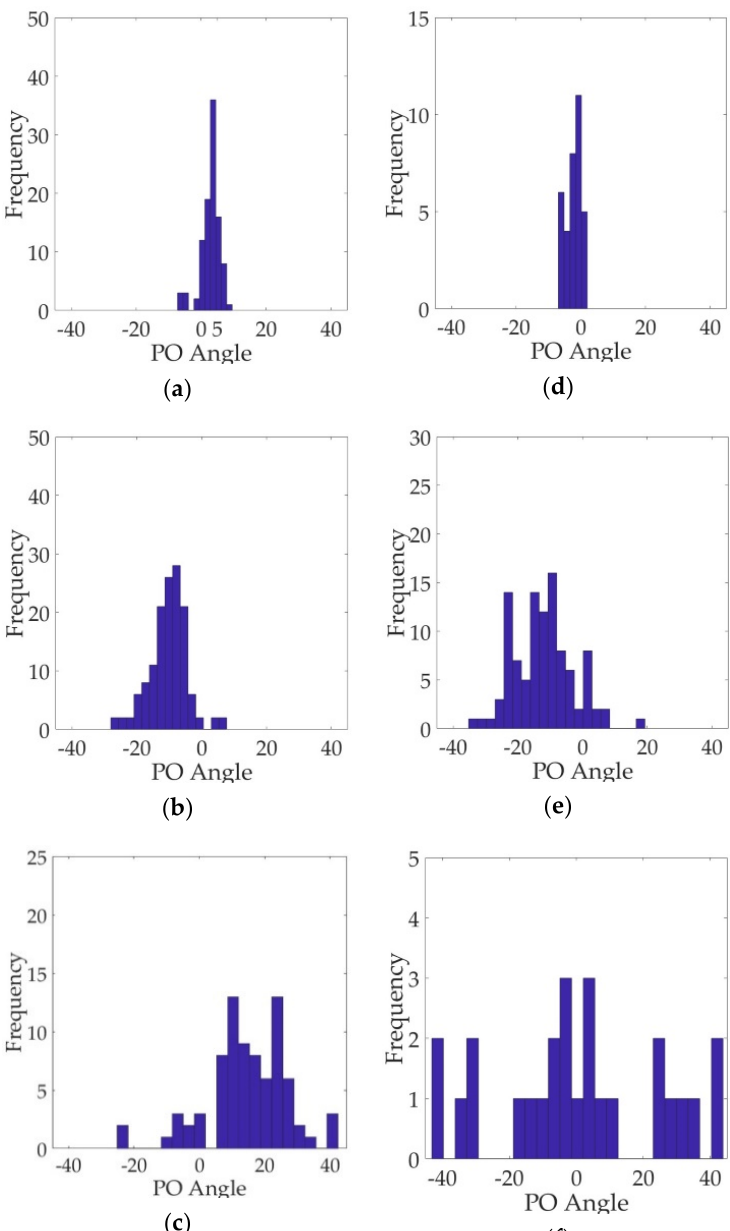
Figure 7. Polarization orientation (PO) angle histograms of ships. ( a – c ) Ships T1–T3 in GF3 data, respectively. ( d – f ) Ships T1–T3 in AIRSAR data, respectively.